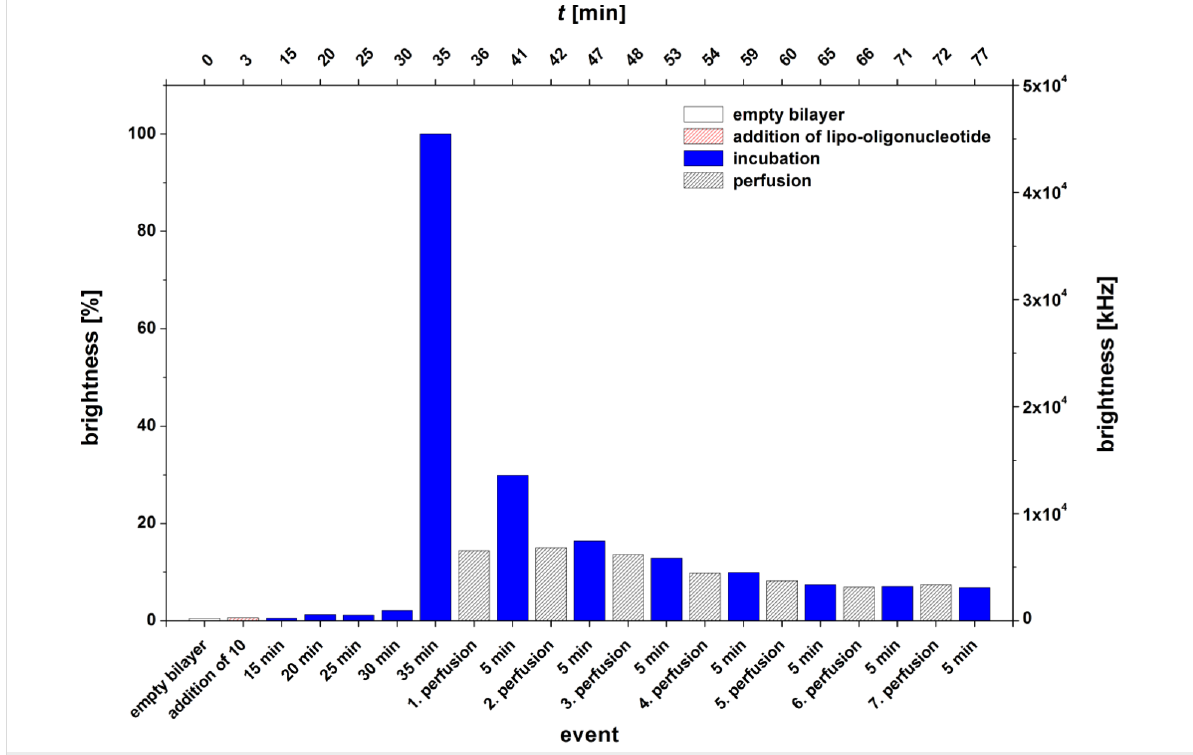
Figure 5: Bilayer brightness vs event graph of 5’-d( 4a -Cy5-TAG GTC AAT ACT) ( 10 ).